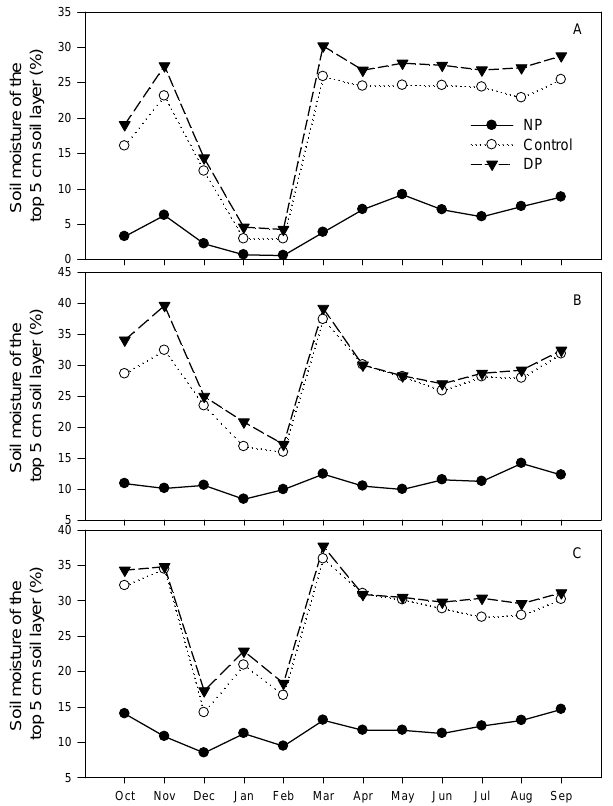
Fig. 1. Seasonal dynamics of soil moisture of the top 5cm soil layer under different precipitation treatments from October 2008 to September 2009 in Masson pine forest (A) , coniferous and broad- leaved mixed forest (B) and monsoon evergreen broad-leaved for- est (C) of Dinghushan Biosphere Reserve. NP, no precipitation; Control, natural precipitation; DP, double precipitation.